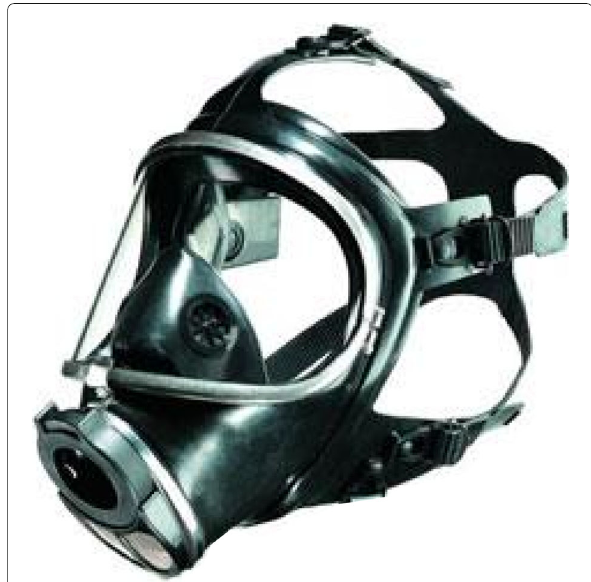
Fig. 1 Full-face mask (model PanoramaNova , Dräger [2])